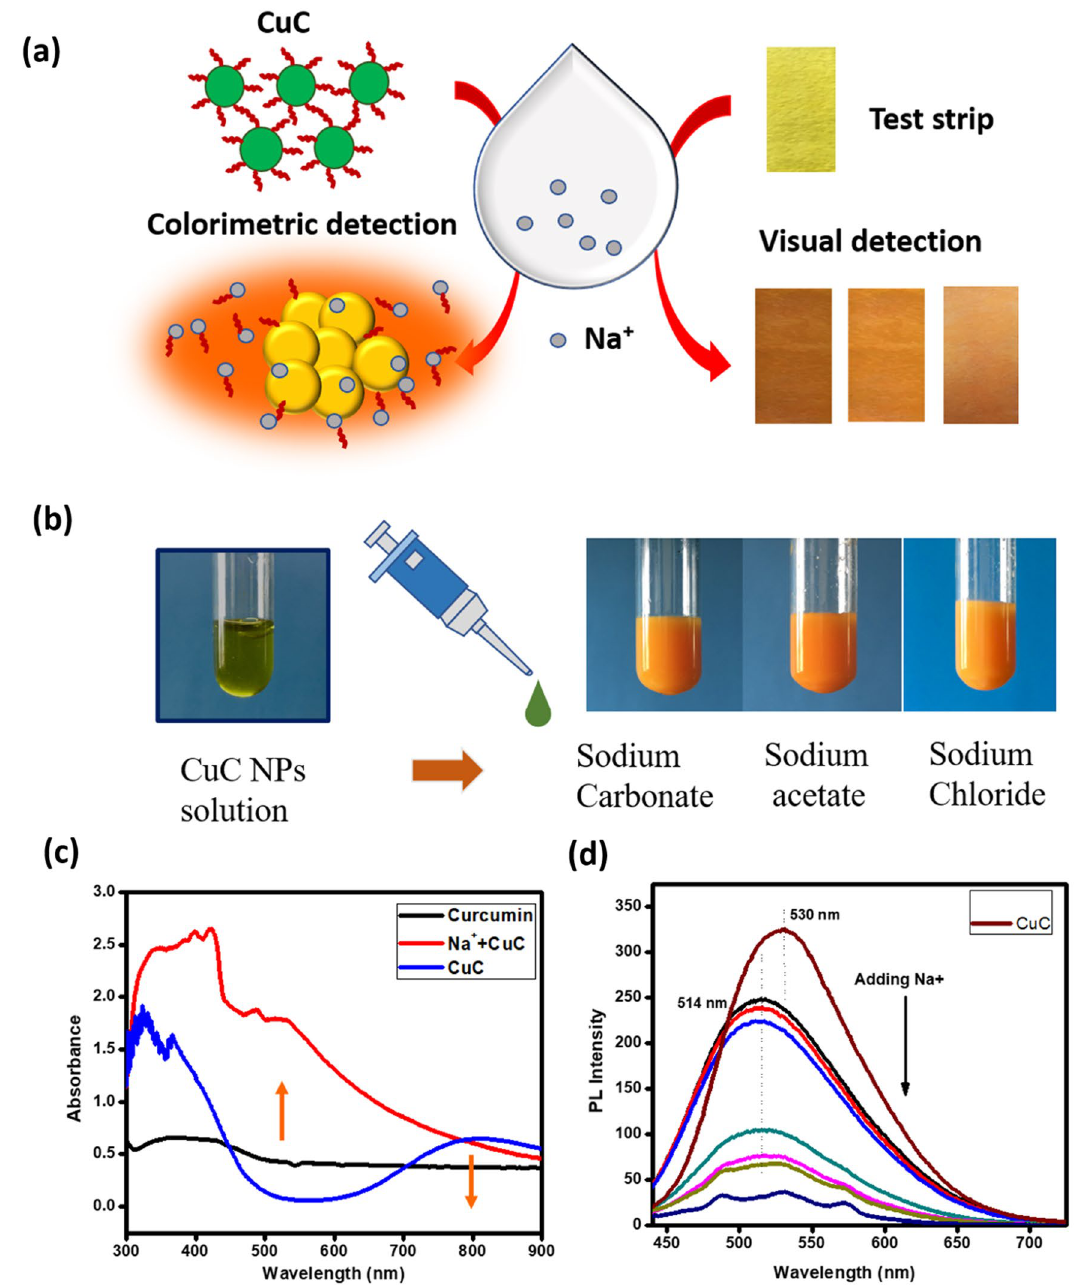
Figure 4. ( a ) Schematic representation showing the mechanism of the selective determination of Na + using CuC based colorimetric probe (Image concept courtesy 38 ). ( b ) Colorimetric detection of Na + from different sources. ( c ) Absorbance spectra of CuC NPs solution before and after the addition of Na + . ( d ) Fluorescent emission spectra of CuC by the addition of different concentration of aqueous solution containing Na +